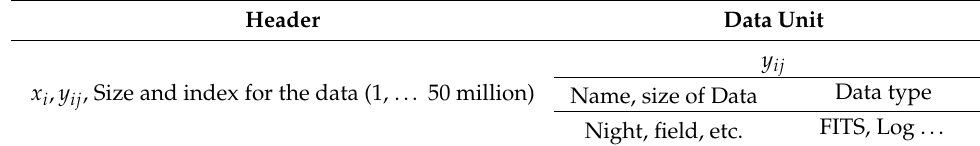
Table 2. ZTF FITS file index in web archive.